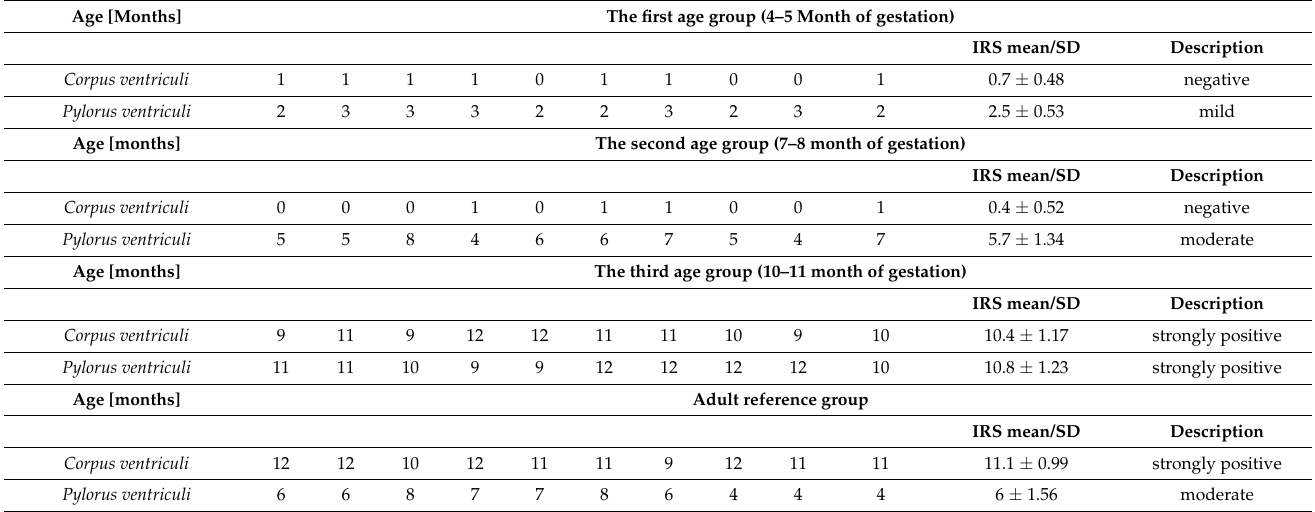
Table 4. Immunoreactivity of anti-cholecystokinin antibody.